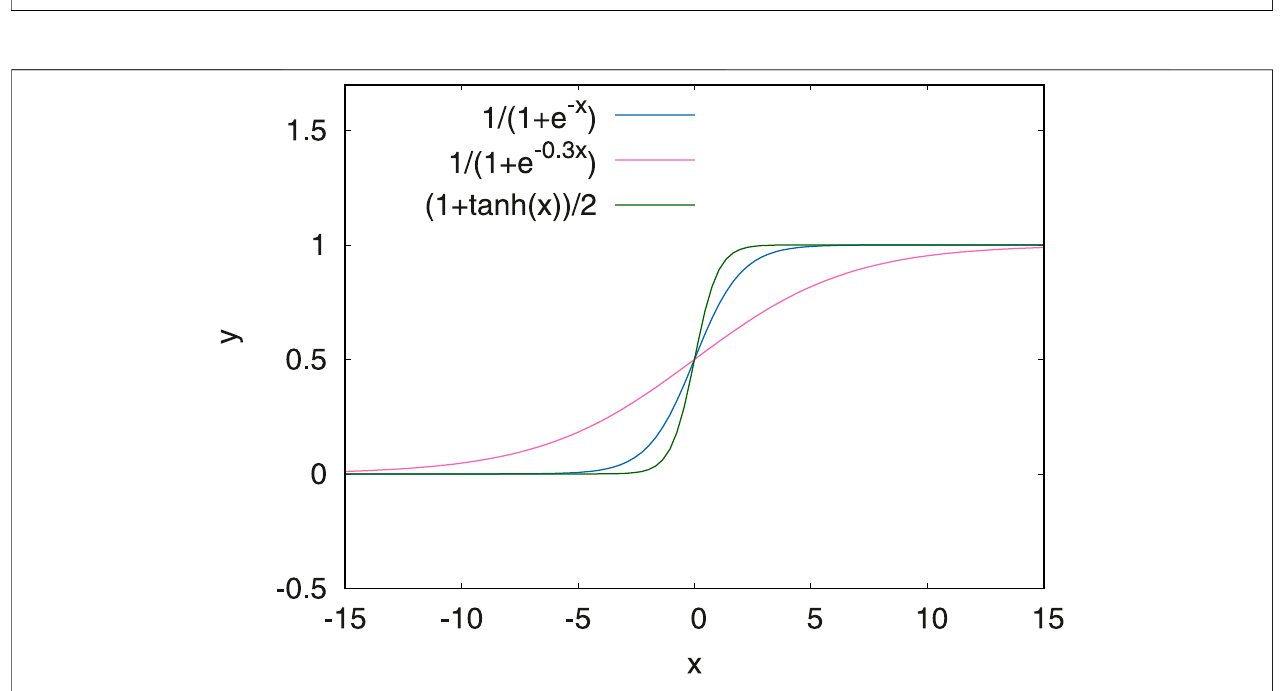
FIGURE3| Normalisationfunctionstestedfortheanomalydetection.The fi rstoneinbluecorrespondstoaSigmoidfunction.Themodi fi edsigmoidfunction(inred) has the advantage of being more linear and fl at around zero.